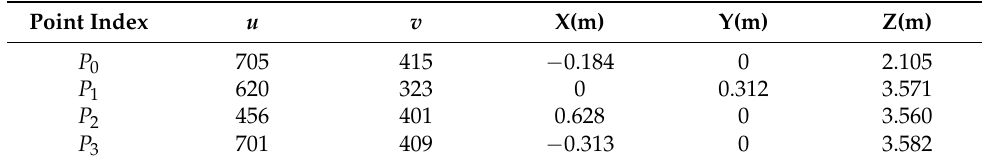
Table 2. Four LiDAR data points and the corresponding pixel information.